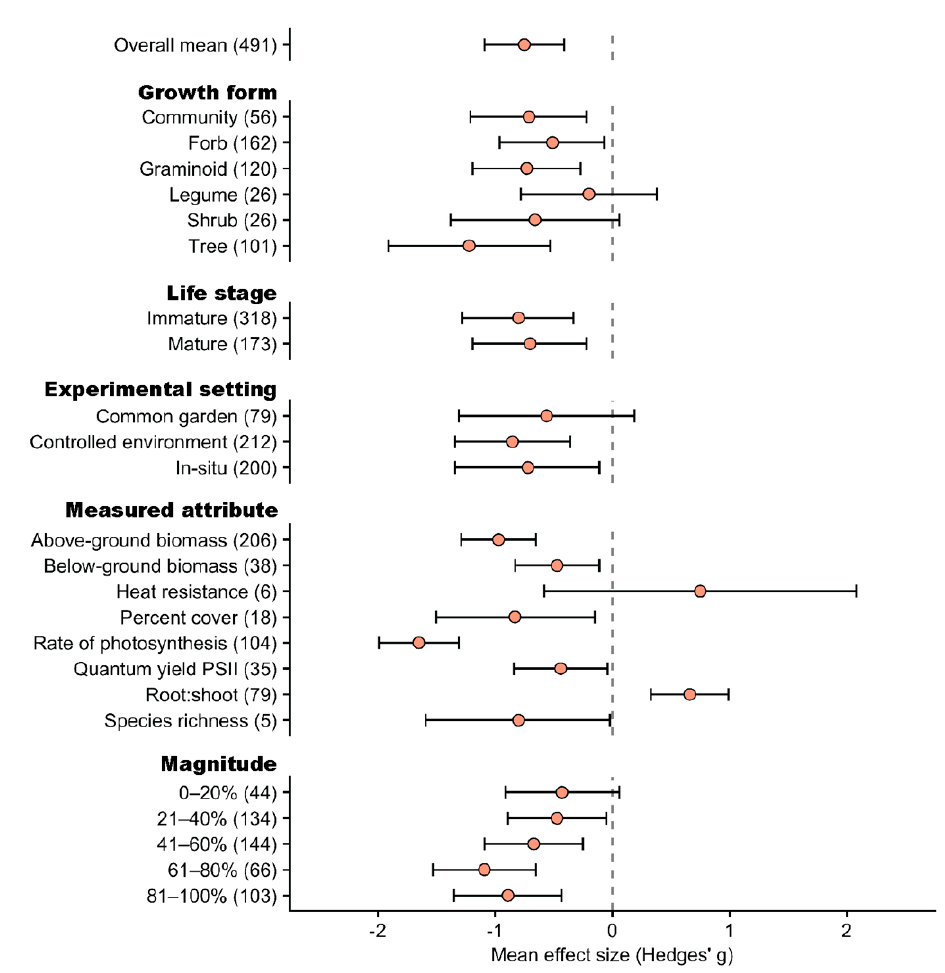
Figure 6. Mean effect sizes (Hedges’ g) and 95% confidence intervals for the effect of reductions to water supply on high elevation plants according to growth form, life stage, experimental setting, response variable measured, and treatment magnitude. Sample sizes for each predictor variable are represented in